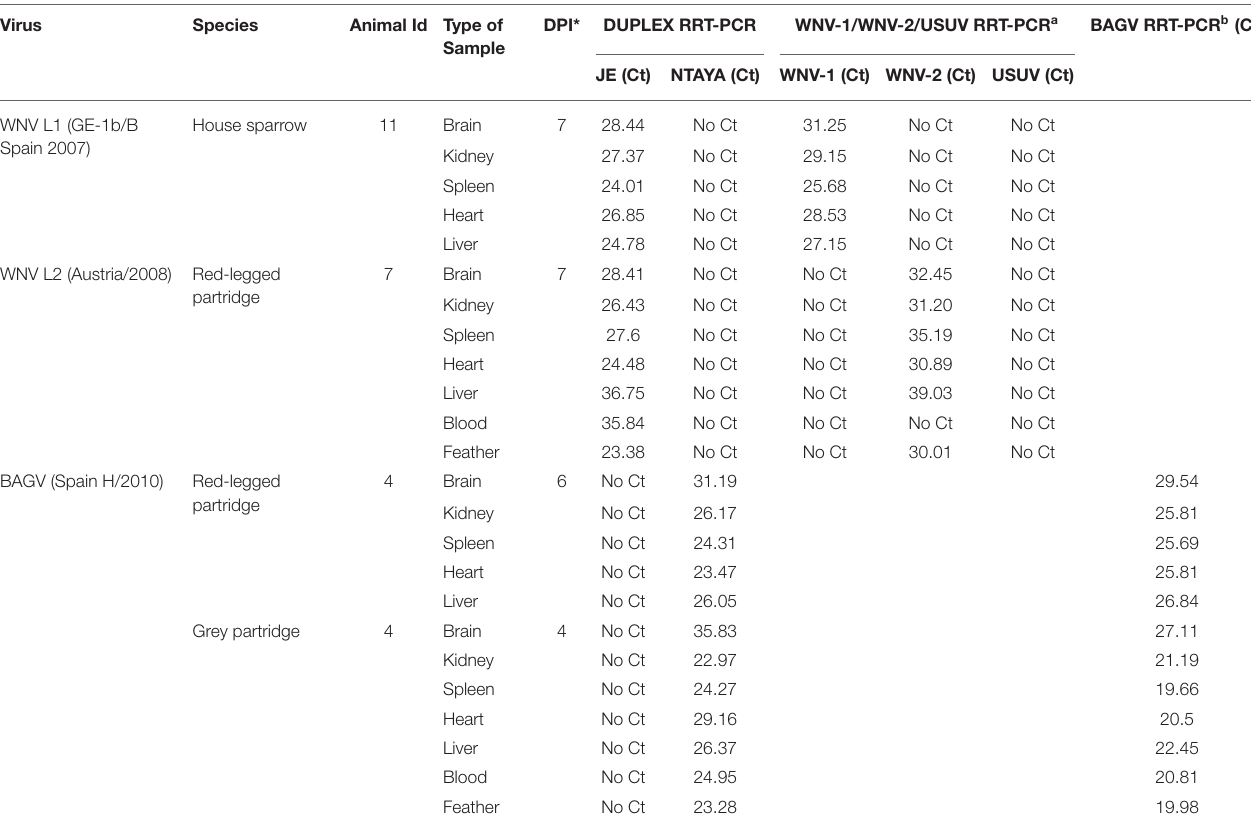
TABLE 2A | Clinical samples used in this study and results obtained by the dRRT-PCR and the RT-PCR methods used as reference; experimental samples from in vivo experiments performed at INIA-CISA.